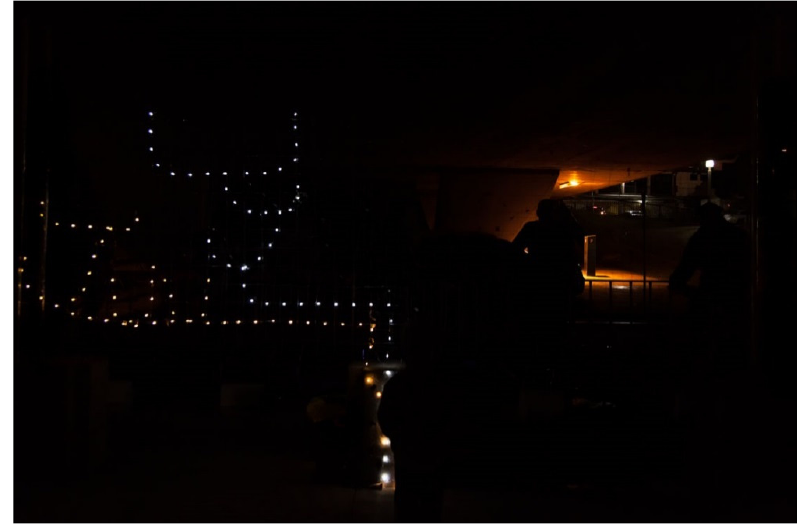
Figure 1. Participant #1 and Participant #2 in sync in ISEA Bright Future (2013).